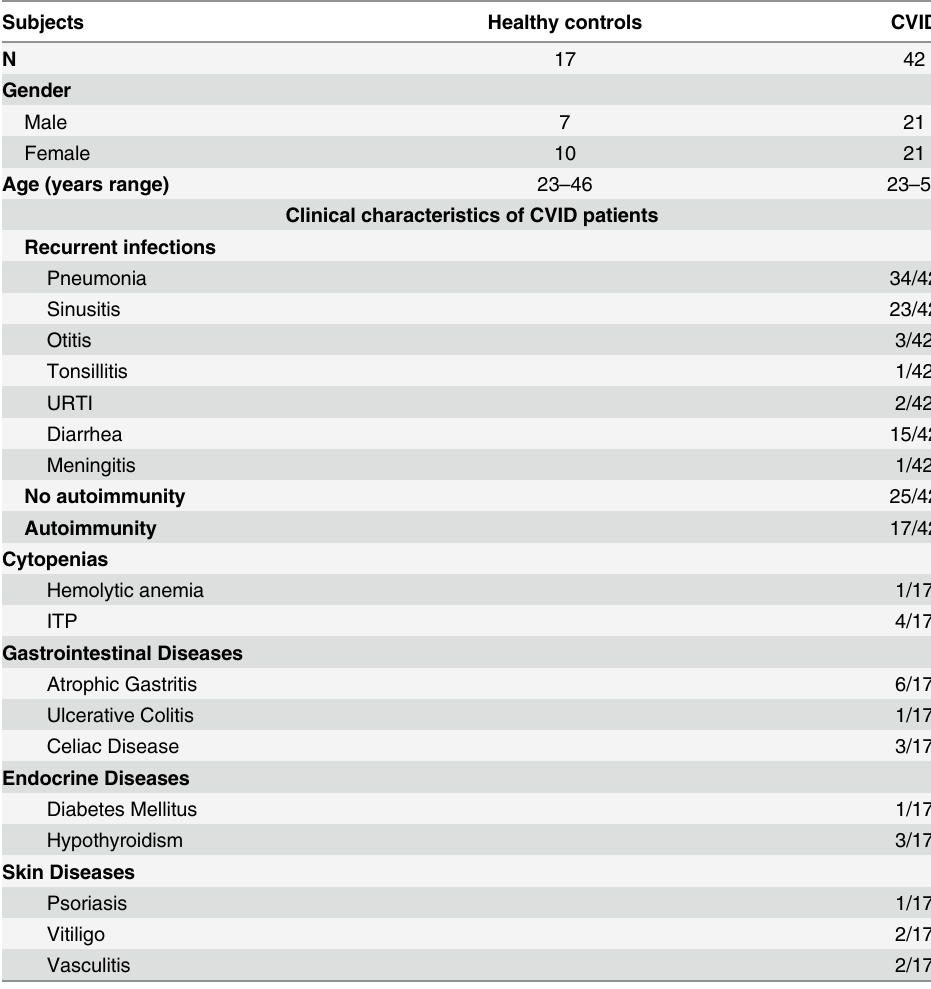
Table 1. Clinical characteristics of CVID patients and healthy controls.